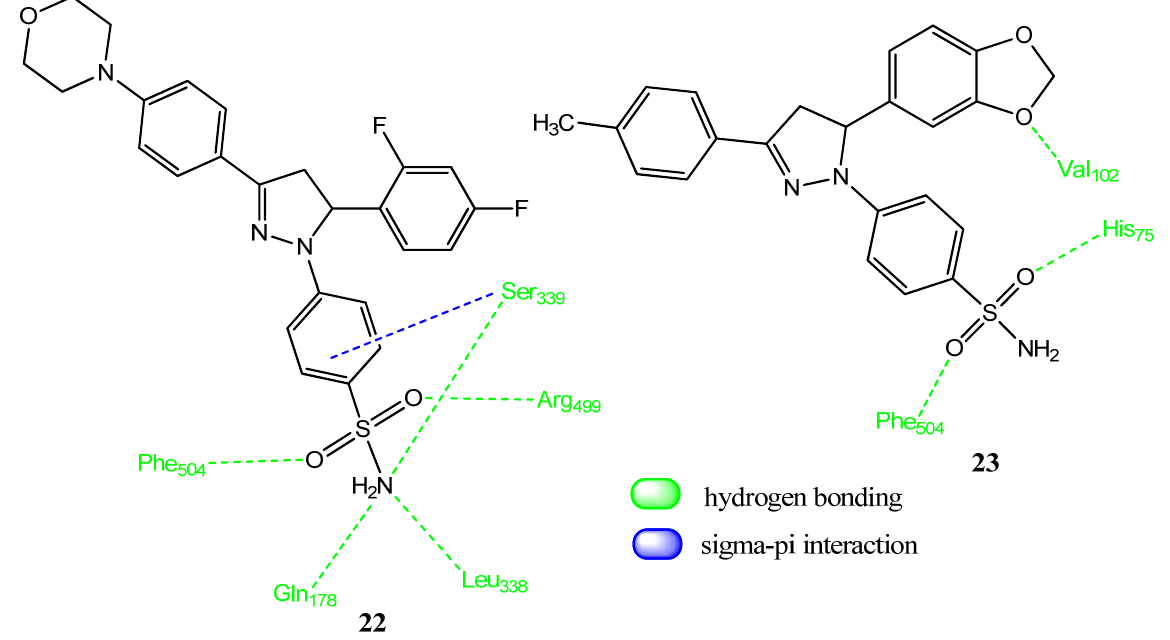
Figure 5. Pyrazoline derivatives and their docking interactions with COX-2.